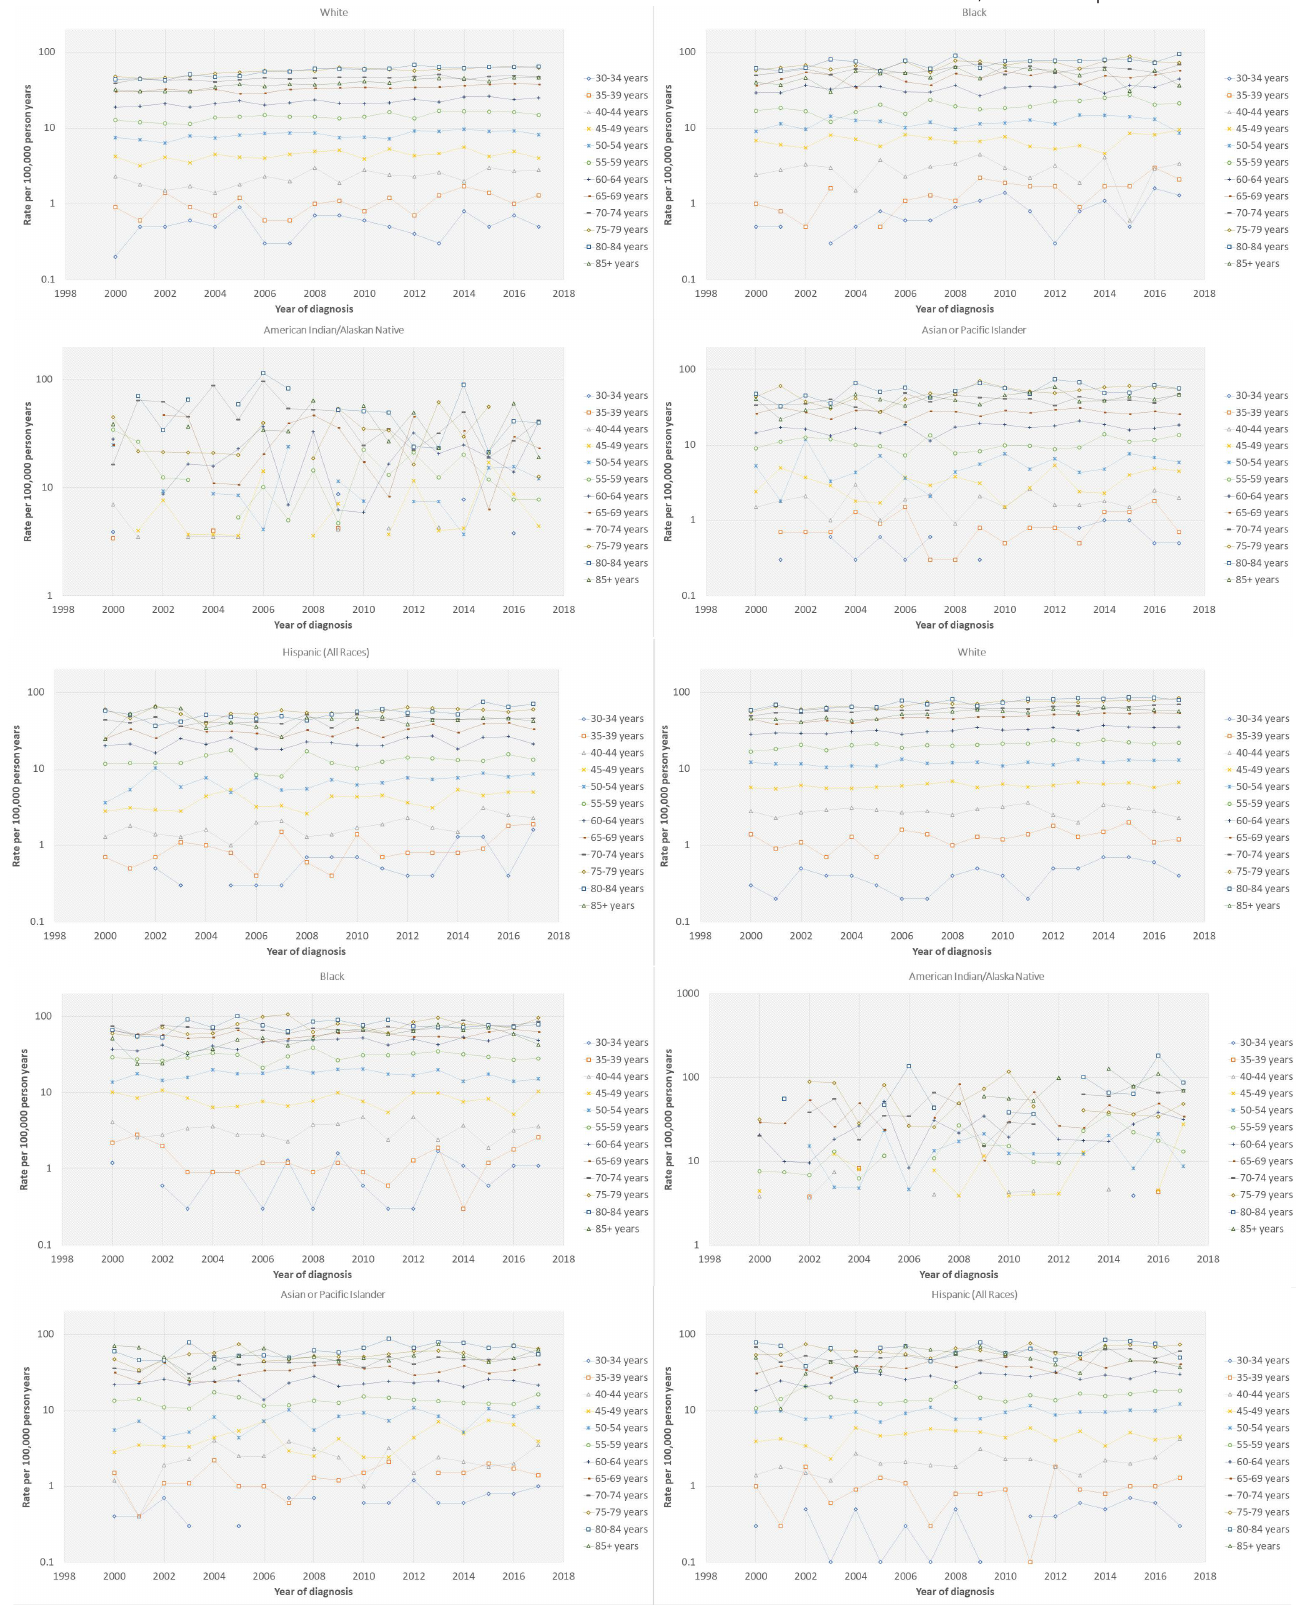
Figure 2. Pancreatic cancer incidence trends by age groups, gender and race based on SEER 18 (2000–2017). a: Males, b: